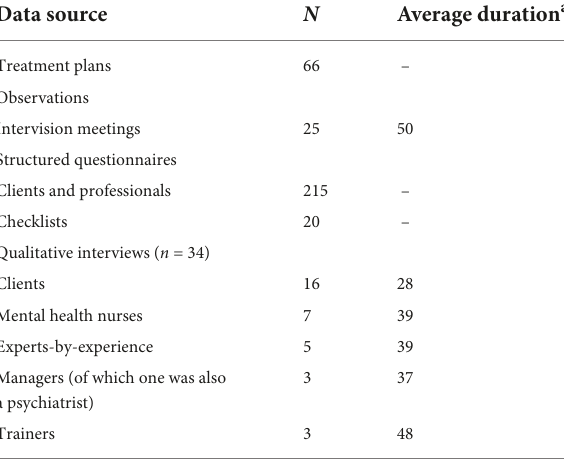
TABLE 2 Data sources included in the